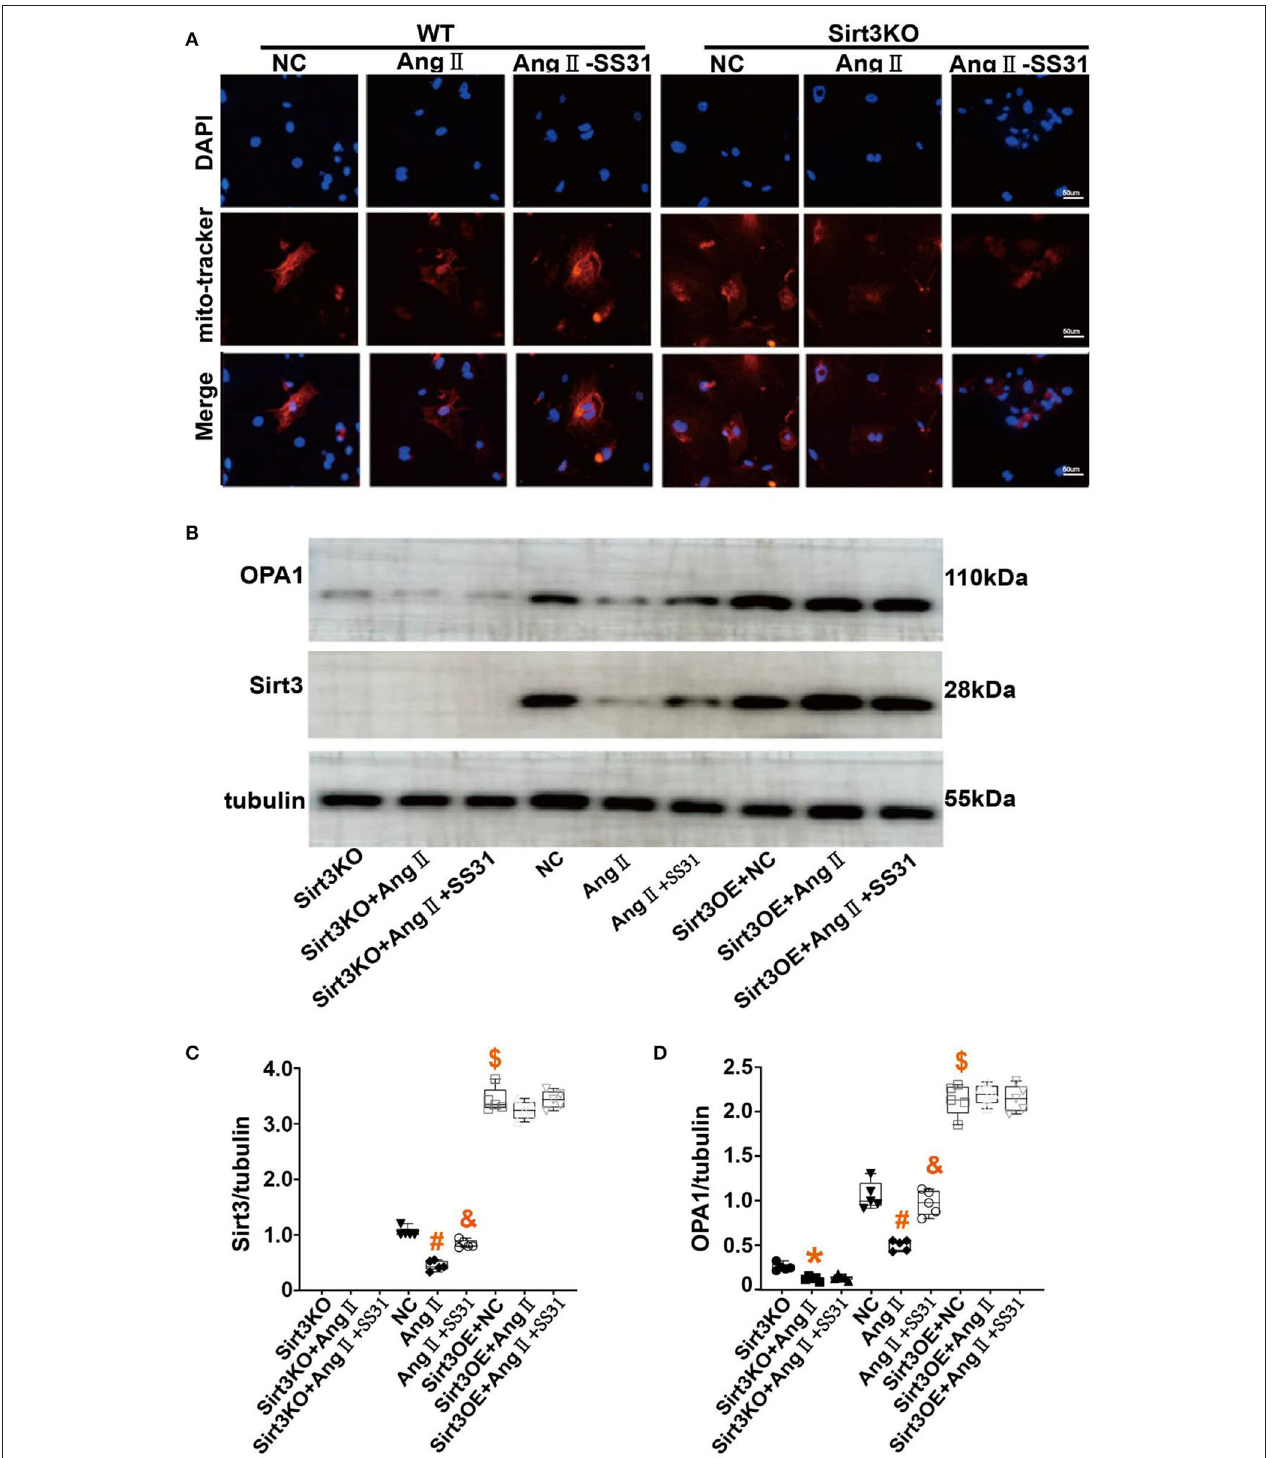
FIGURE 5 | SS31 regulates mitochondrial fusion in fibroblasts. (A) Immunofluorescence staining of mitochondria in cells to observe the morphology of mitochondria. Red represents mitochondria and blue represents the nucleus. (B–D) Western Blot to observe the role of SS31 in the transdifferentiation of cardiac fibroblasts. (B) Western blot pictures of Sirt3 and OPA1 between different groups; (C) Western blot statistical analysis of Sirt3; (D) Western blot statistical analysis of OPA1. (The results are expressed as the means ± SEM, n = 3. The one-way ANOVA test was used, and n represents the number of independent experiments. * p < 0.05 vs. Sirt3KO group; # p < 0.05 vs. WT + NC group; & p < 0.05 vs. WT + Ang II group; $ p < 0.05, Sirt3OE vs. WT + NC group).